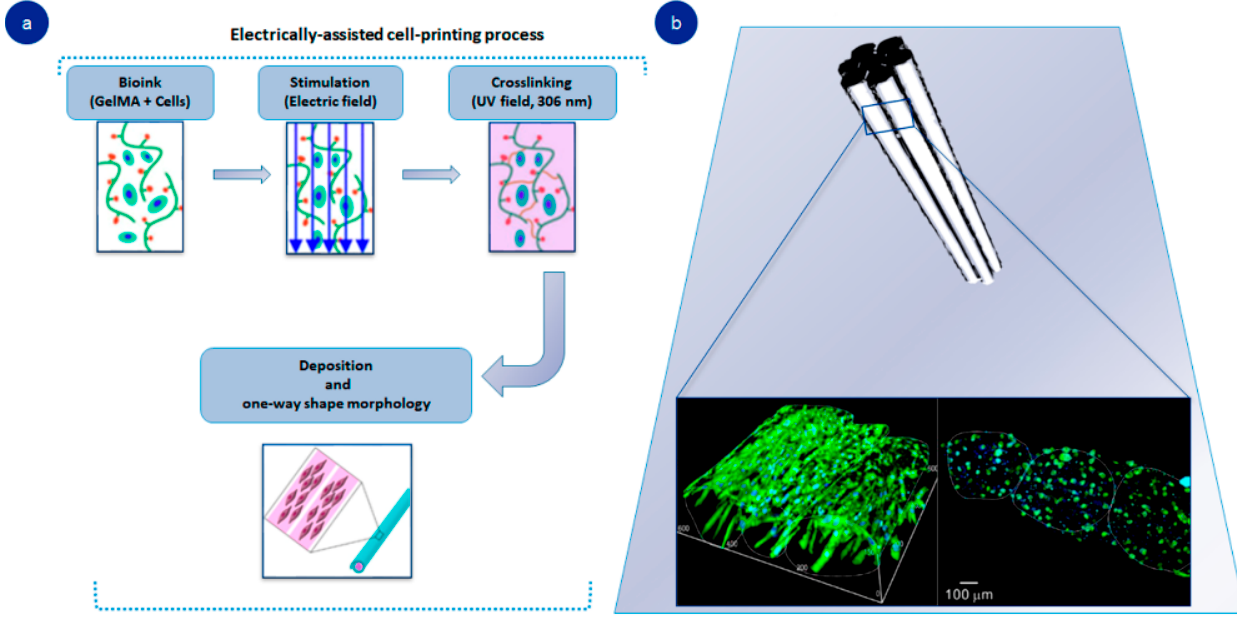
Figure 2. Gelatin-based 4D-printed hydrogel: ( a ) manufacturing process of 4D-printed hydrogel; ( b ) DAPI/MHC cross-sectional images of fibers after 21 days. Adapted with permission from Yang et al. [43]. Theranostics, published by Ivyspring International Publisher, copyright 2021.